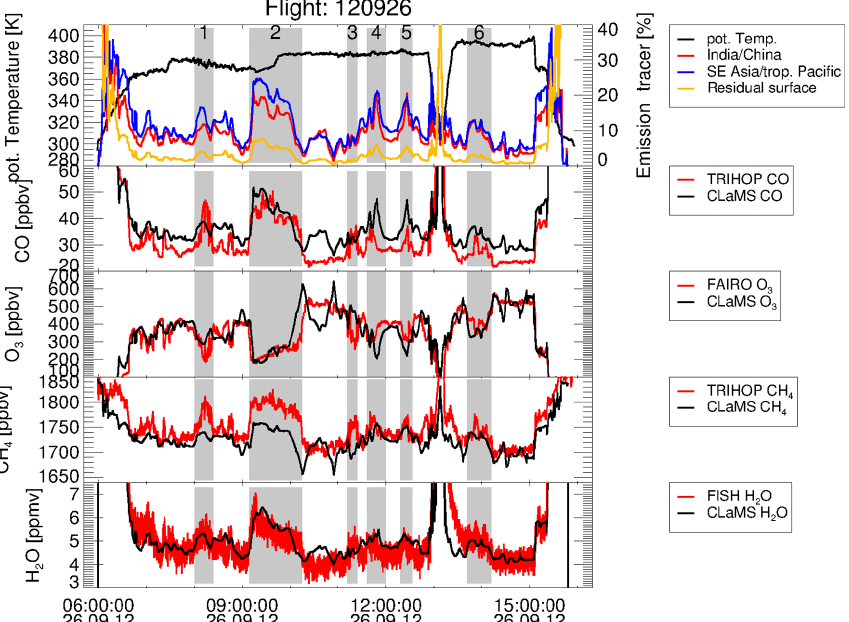
Figure 9. Top panel: time evolution (given in UT time) of potential temperature, the fraction of air originating in India/China, south- east Asia/tropical Pacific and of the residual surface (sum of all other emission tracers covering the entire Earth’s surface) simulated with CLaMS for the flight on 26 September 2012. Middle and lower panel: CO, O 3 , CH 4 , and H 2 O simulations and measurements. Segments of the flight in the lower stratosphere with enhanced measured CO, CH 4 , and H 2 O, and reduced O 3 compared to the stratospheric background are highlighted in gray and numbered for